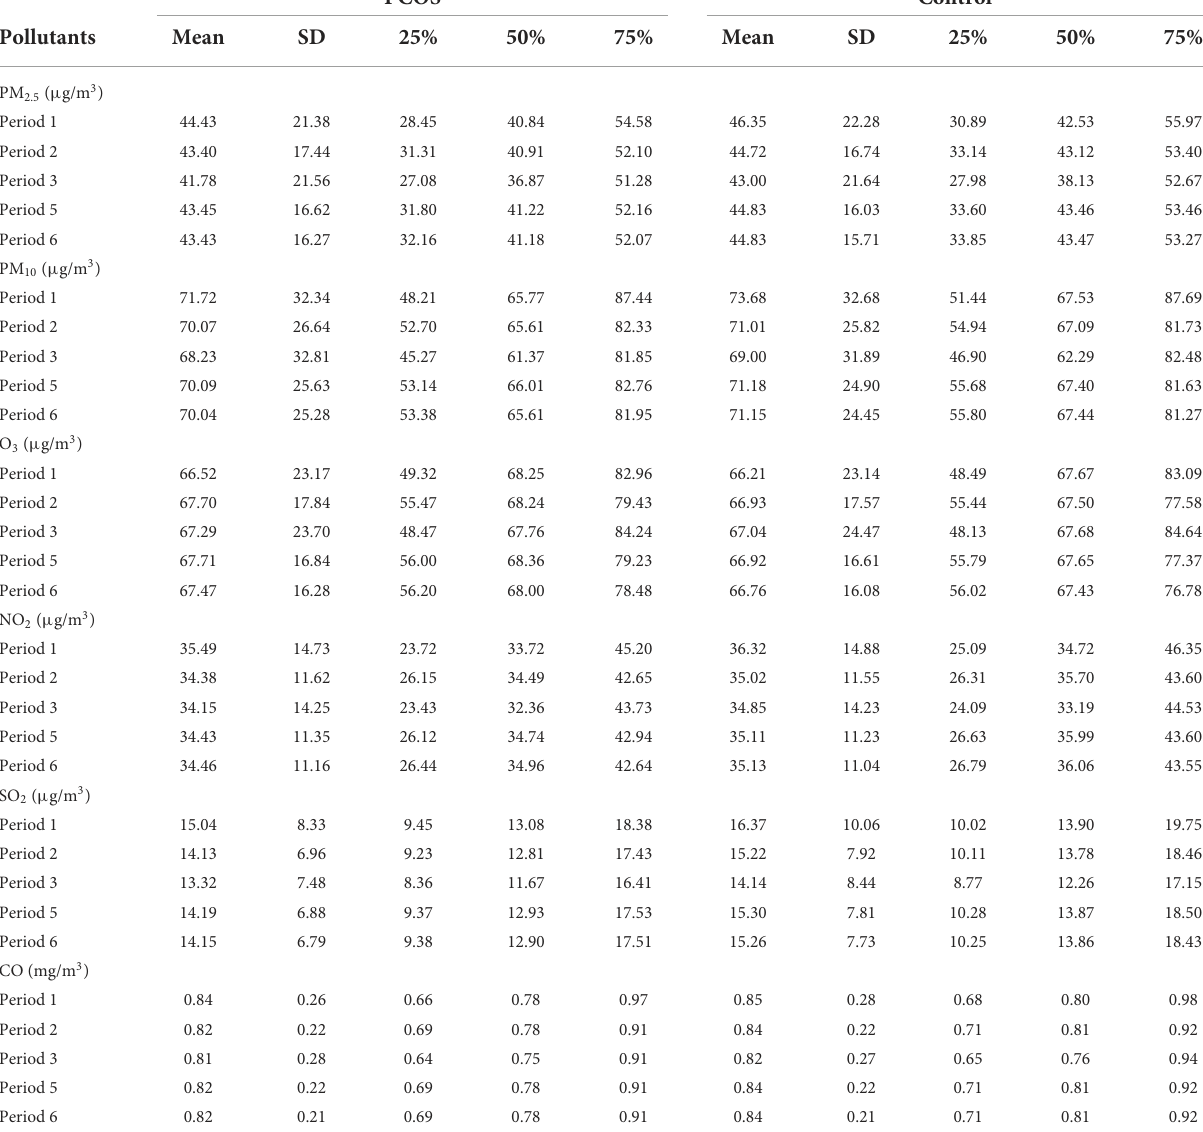
TABLE 2 Distributions of six air pollutants during different exposure periods among women with and without PCOS. PCOS